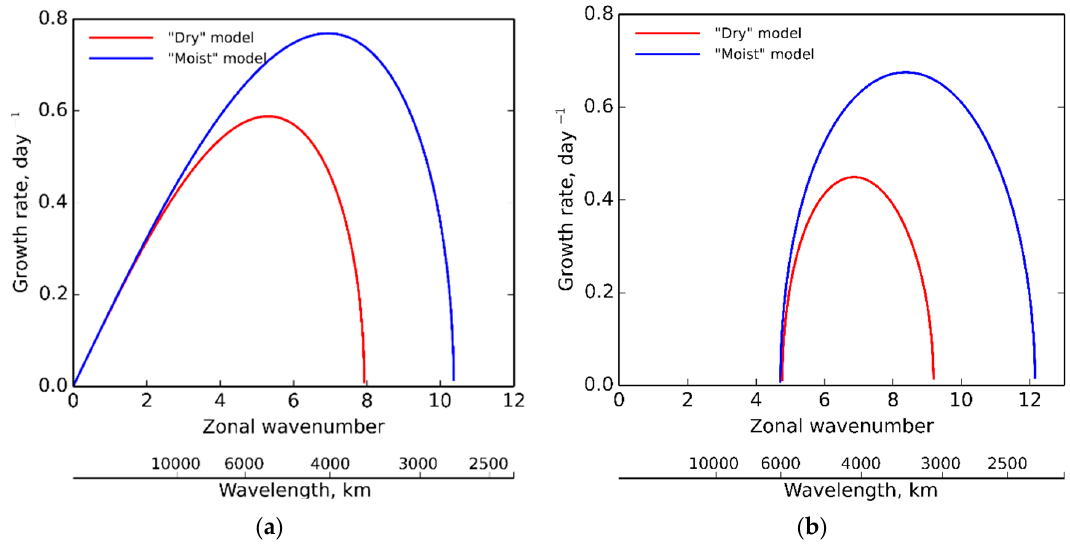
Figure 1. Growth rate χ k = kc i as a function of zonal wavenumber k z for the “dry” and “moist” ( a ) f -plane and ( b ) β -plane models, as described by Equations (10) and (15) Table 1. Characteristics of baroclinic instability obtained from the f -plane and β -plane models.